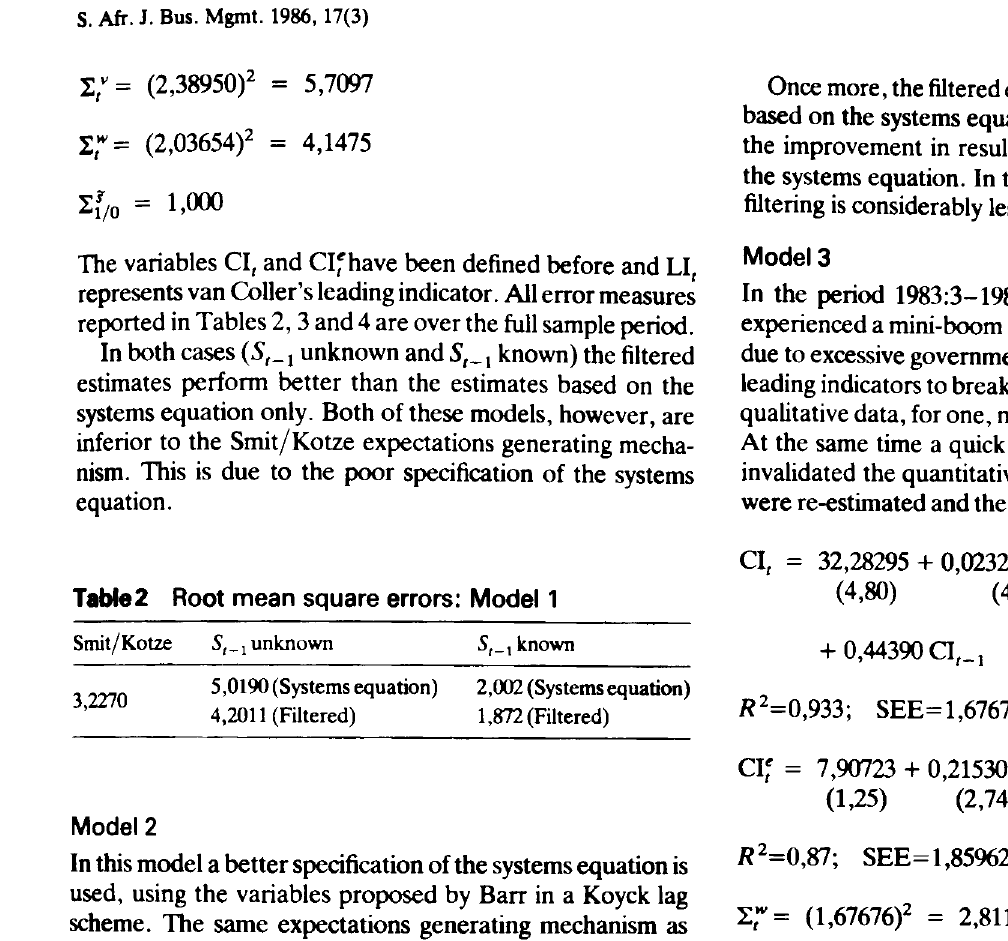
Table4 Root mean square errors: Model